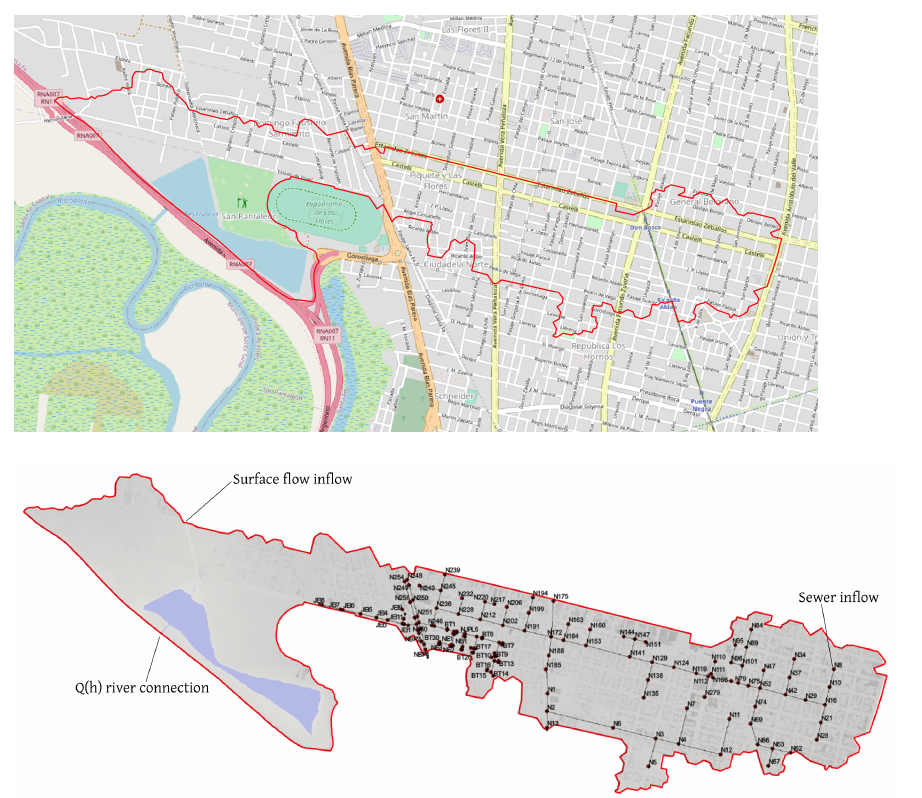
Figure 10. Case 3: Map of the considered area with the domain limitation ( upper ) and position of the 147 surface-sewer links ( lower ). Surface boundary conditions and sewer inflow is also depicted.